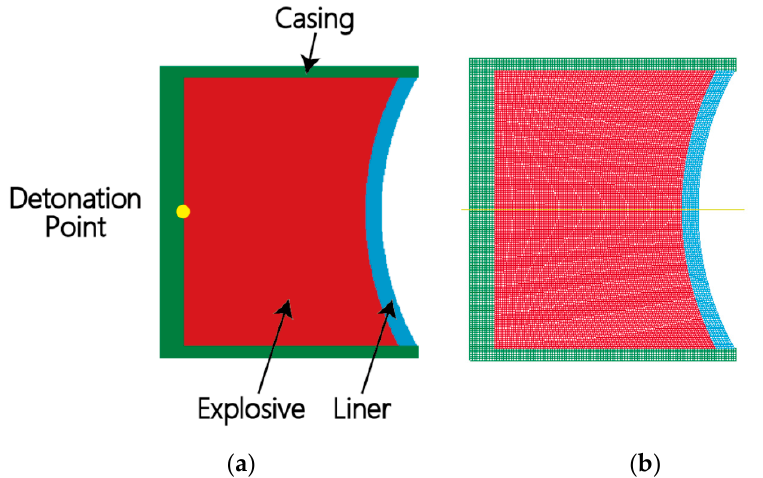
Figure 8. Numerical and grid model of EFP charge structure. ( a ) Diagram of numerical model. ( b ) Grid model.